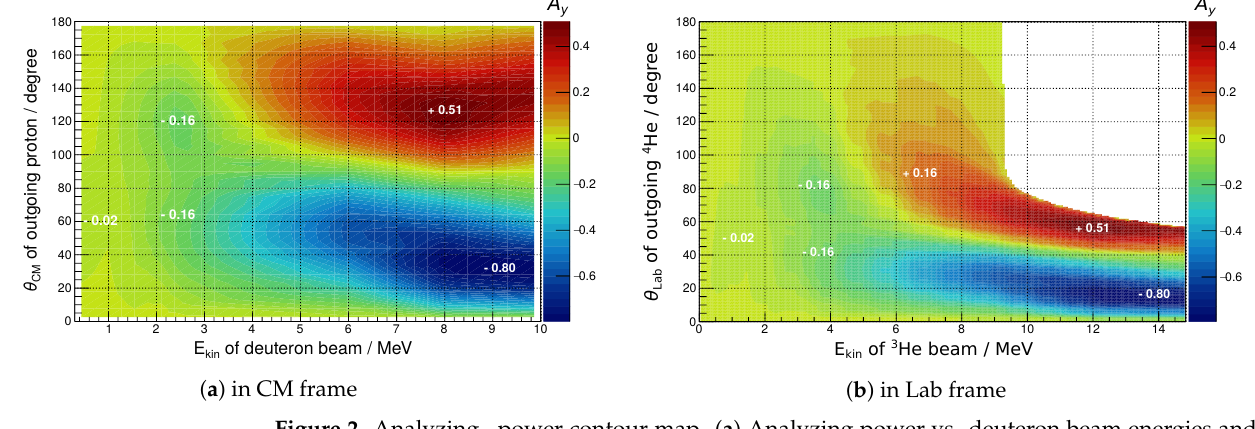
Figure 2. Analyzing − power contour map. ( a ) Analyzing power vs. deuteron beam energies and outgoing proton polar angles in the CM frame. ( b ) Analyzing power vs. 3 He beam energies and outgoing 4 He polar angles in the Lab